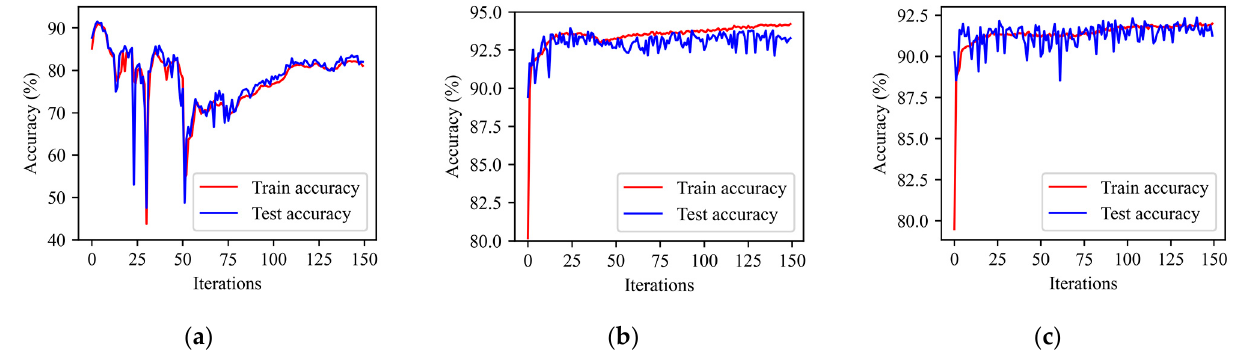
Figure 4. Change curve of classification accuracy of three deep learning algorithms. ( a ) BP ‐ STIP learning algorithm; ( b ) FA ‐ STIP learning algorithm; ( c ) BA ‐ STIP learning algorithm.